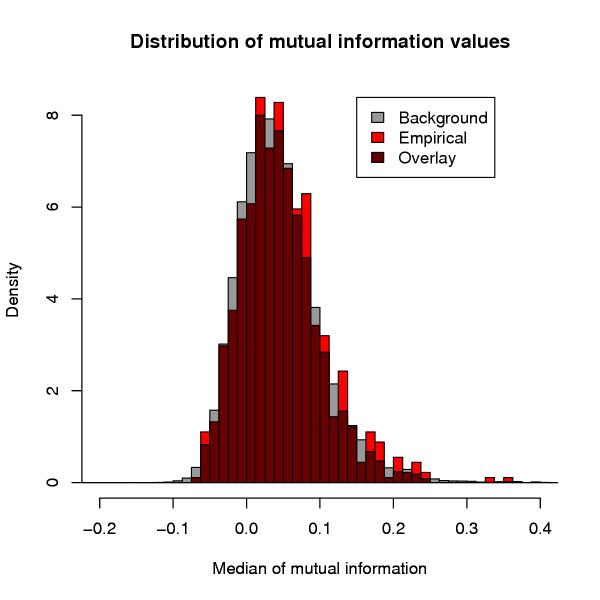
Distribution of mutual information. For each interaction pair and for each dataset we calculated the mutual information of expression levels of genes encoding interacting protein pairs. The graph shows empirical and background distribution to be very similar.